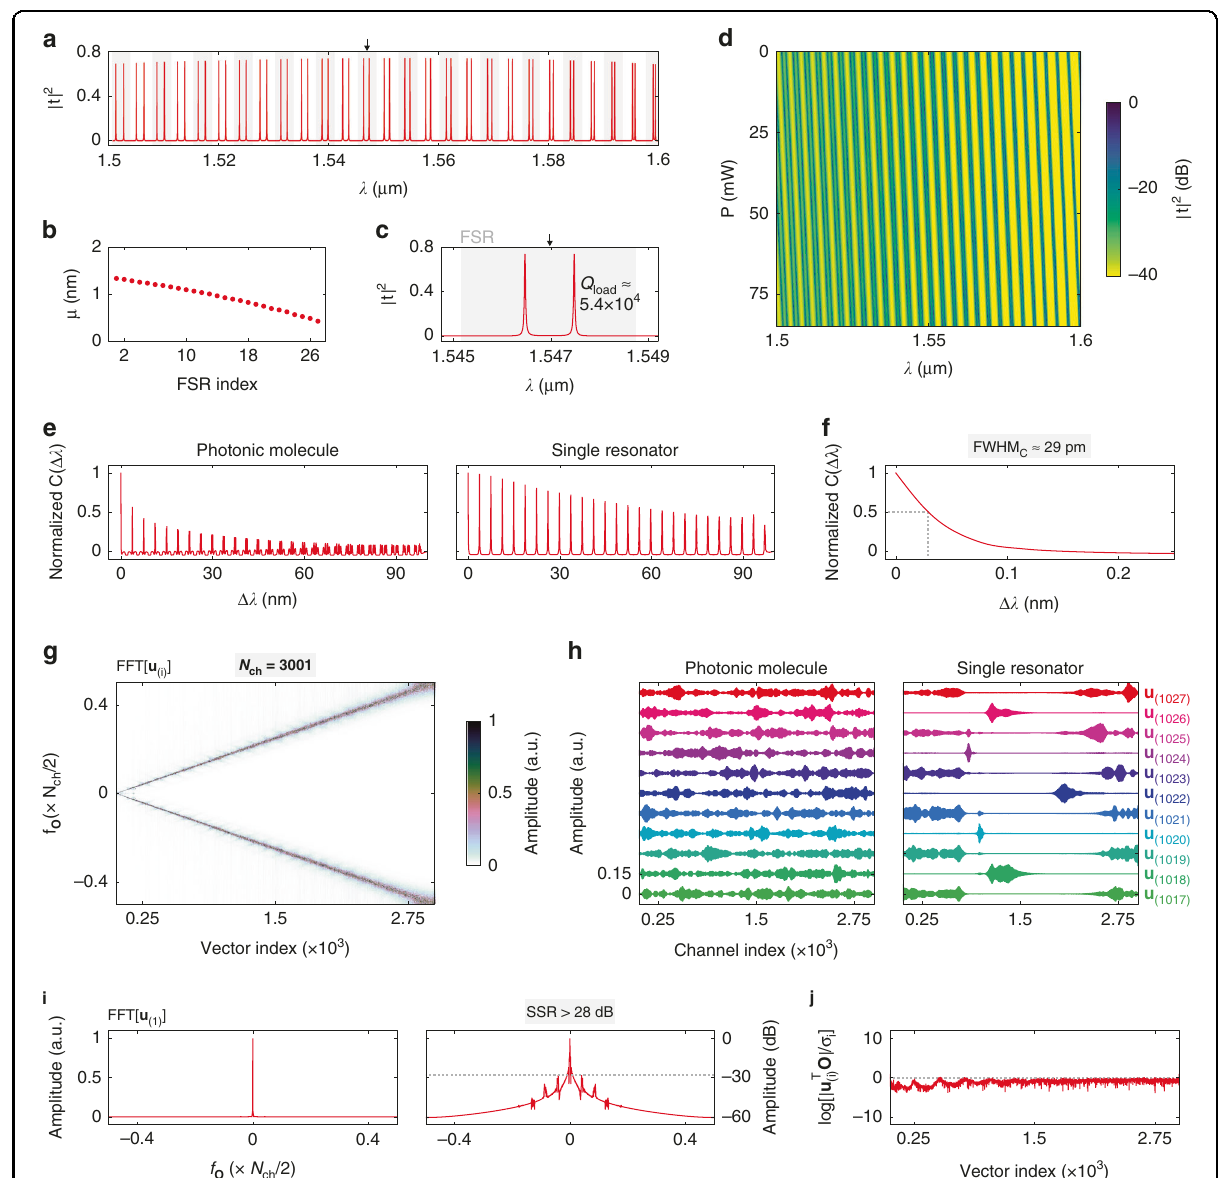
Fig. 4 Analysis of the spectrometer. a Calculated transmission response (| t | 2 ) of the optimized spectrometer with zero heating-power applied. b Extracted splitting strengths ( μ ) at different free-spectral ranges (FSR). c Enlarged view of | t | 2 in the vicinity of a single FSR. d Calculated transmission matrix ( A ). e Calculated correlation functions [ C ( Δ λ )] for the photonic molecule (left panel) and a single resonator (right panel). f Enlarged view of C ( Δ λ ) around Δ λ = 0. The dashed line depicts the full width at half maximum (FWHM C ). g Fast Fourier-transform (FFT) result for the left singular vectors [ u ( i ) ] of A . h Calculated u ( i ) for the photonic molecule (left panel) and a single resonator (right panel) around the 7-th overtone of FSRs. i FFT result for the fi rst left singular vector [ u (1) ] at the linear (left panel) and logarithmic (right panel) scales. The dashed line depicts the sideband suppression ratio (SSR). j Calculated absolute values of SVD coef fi cients [| u T ( i ) O |/ σ i ]. The dashed line depicts | u T ( i ) O |/ σ i =